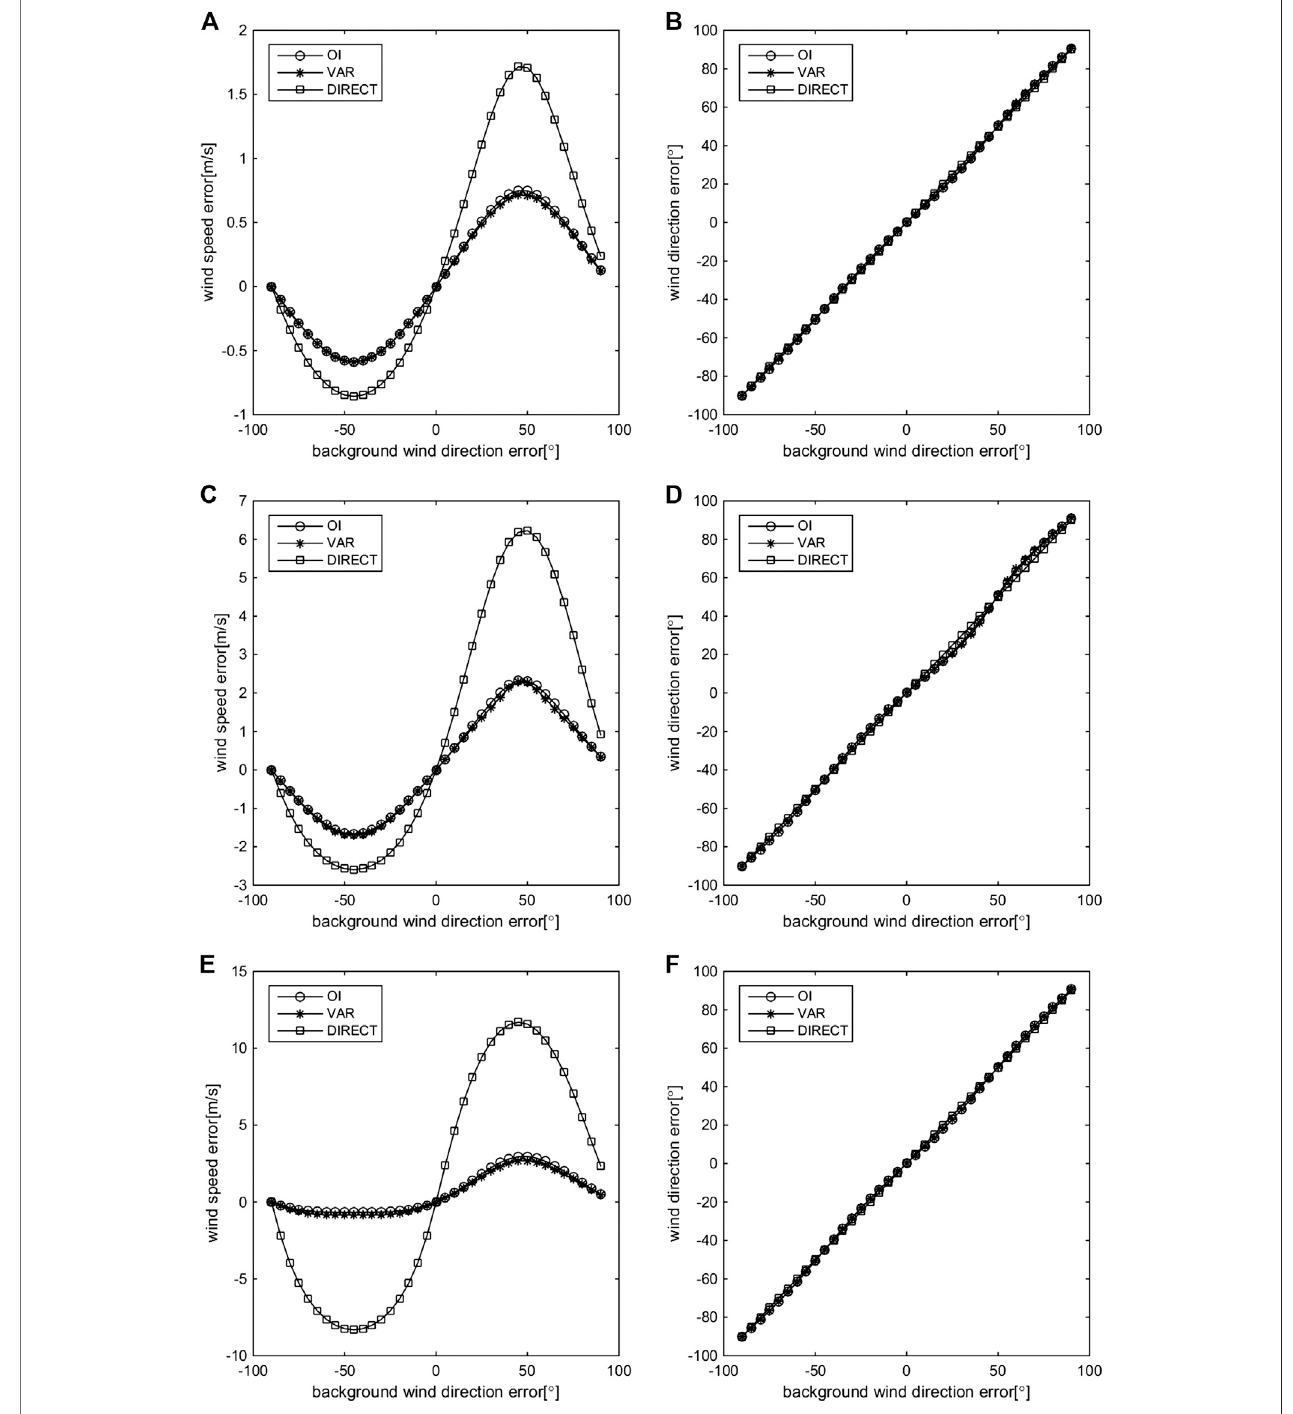
FIGURE7| RetrievedwinderrorsoftheOI,VAR,andDIRECTmethodswhenthebackgroundwindspeedsare5 m/s (A , B) ,12 m/s (C , D) ,and25 m/s (E , F) ;the background wind speed contains no errors, and the background wind direction contains regular errors.